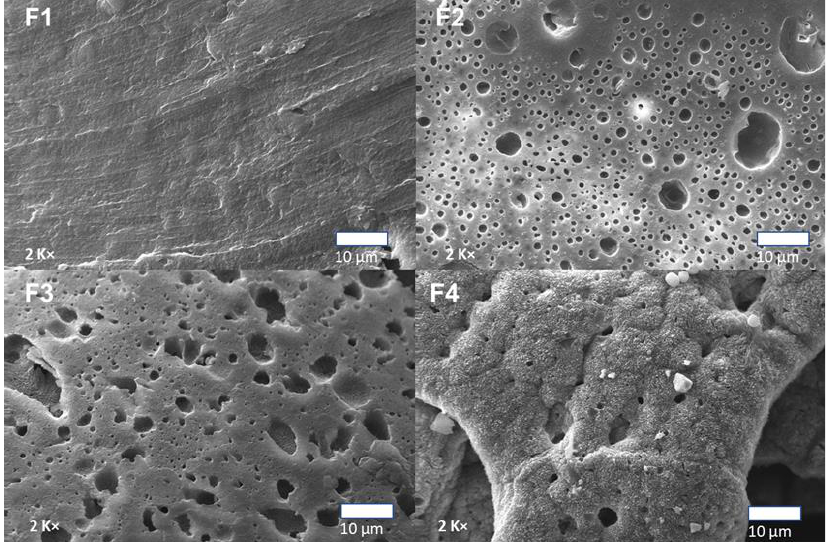
Figure 6. Scanning electron micrographs of membranes PCL/PLA/TiO 2 /OEO. F1, 30% PCL/70% PLA; F2, 27% PCL/70% PLA/3% TiO 2 ; F3, 20% PCL:70% PLA:10% OEO; F4, 17% PCL:70% PLA:3% TiO 2 :10%